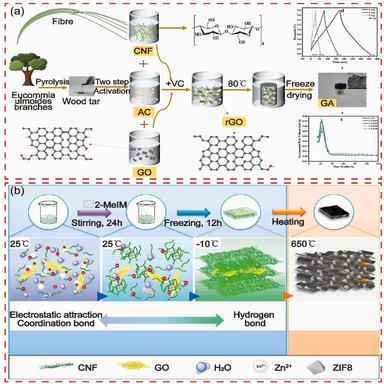
(a) Schematic illustration of the process of preparation of CAs. (b) Schematic illustration exhibiting the preparation processes of CCGZ film. (a) Images reprinted with permission from. (b) Images reprinted with permission from (.